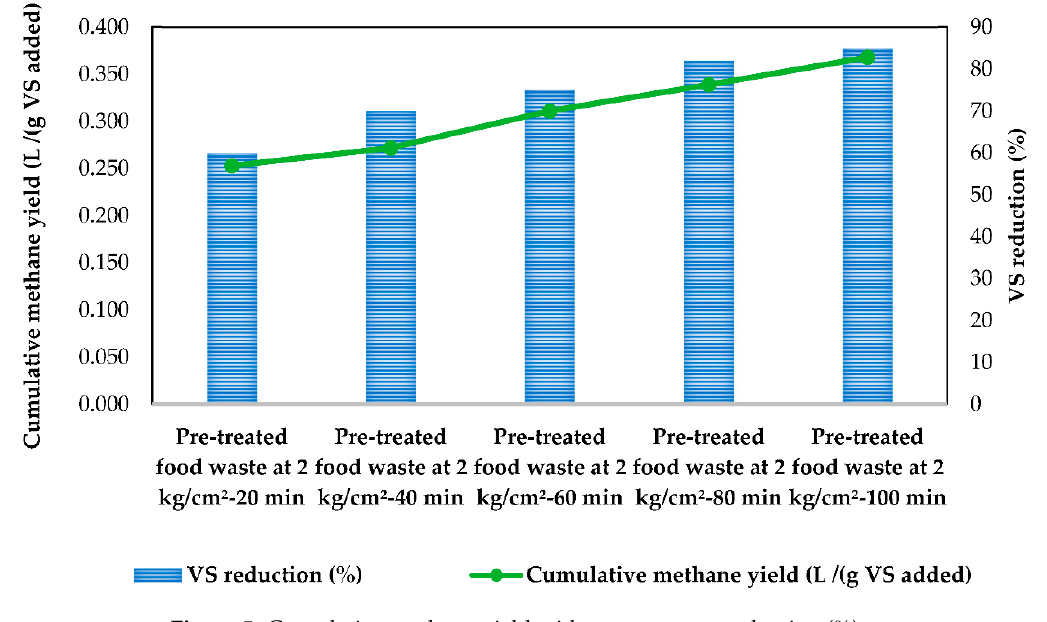
Figure 5. Cumulative methane yield with respect to vs. reduction (%).